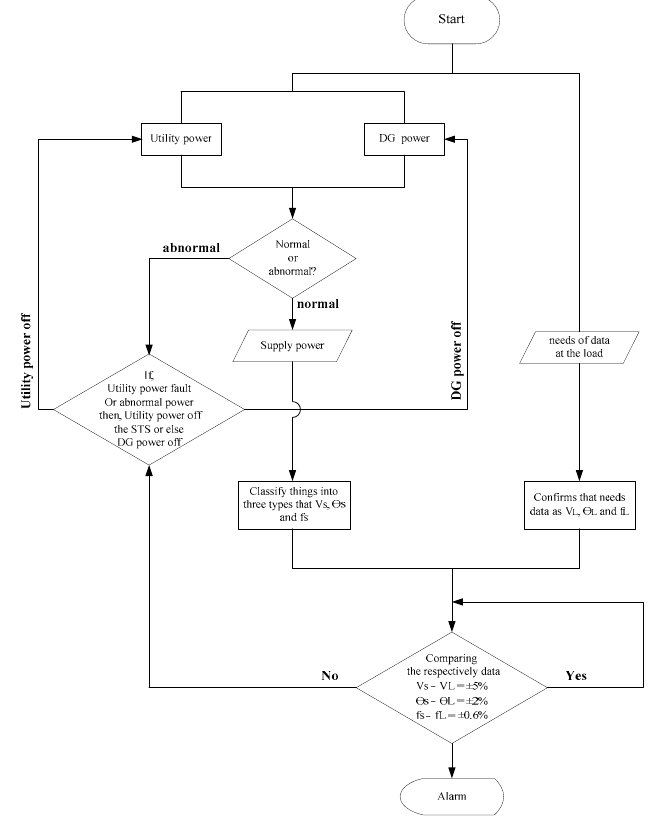
Figure 3. Switchgear panel’s control algorithm.